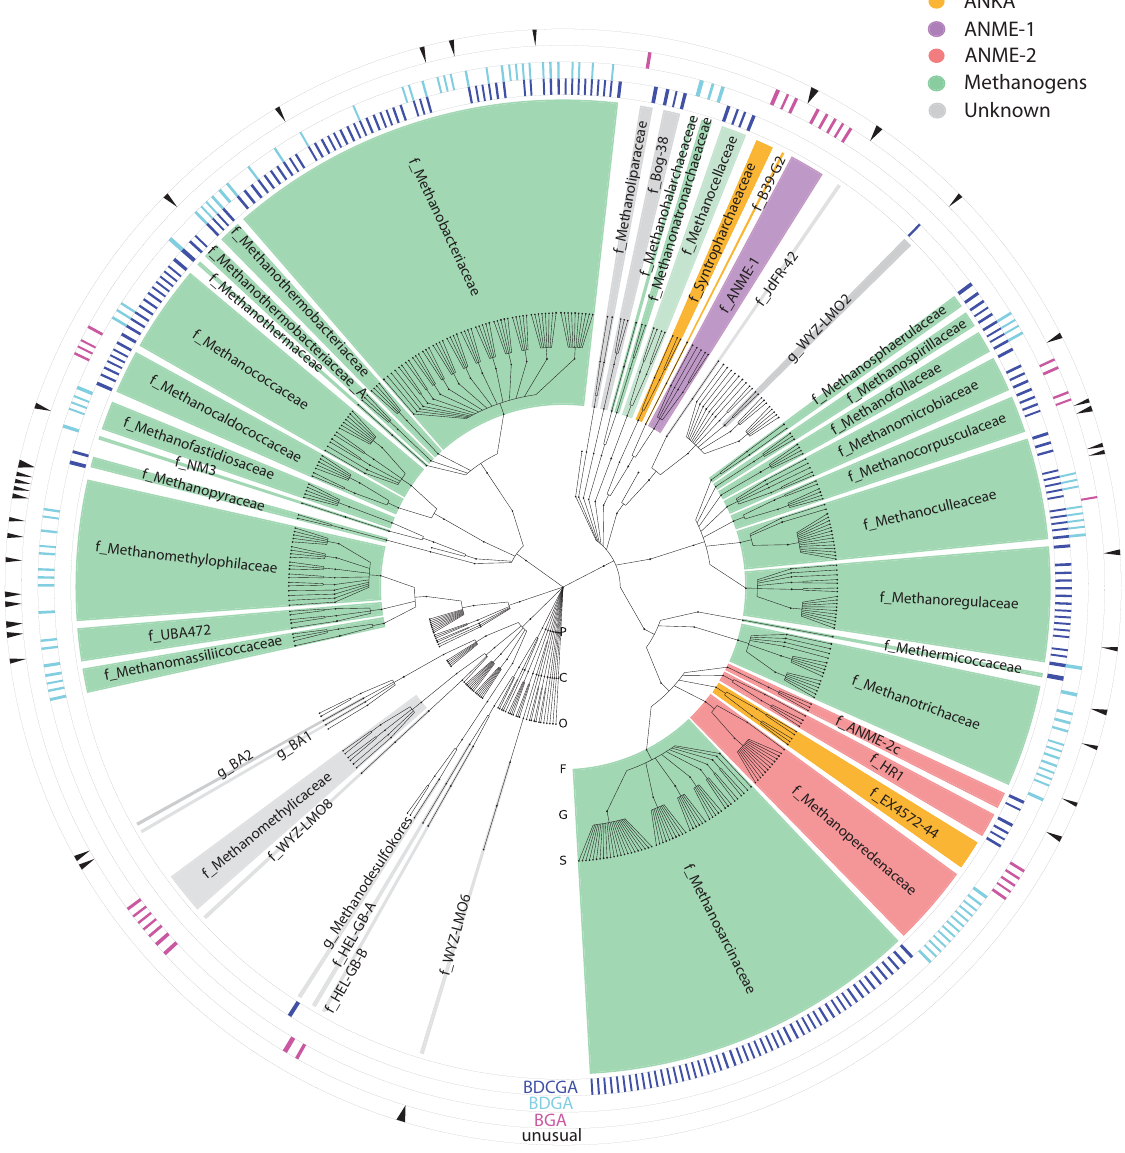
Fig. 1 Distribution and gene clusters of mcr among archaea. A total of 307 mcr genes were identi fi ed from 1070 archaeal genomes including methanogens ( n = 252), ANME-1 clade ( n = 5), ANME-2 ( n = 20), ANKA ( n = 9), and other archaea with unknown metabolism ( n = 21). Accession numbers are given in Supplementary Data 1. Color shading: green, methanogens; purple, ANME-1 archaea; red, ANME-2 archaea; orange, proposed ANKAs; gray, archaea containing mcr with unknown functions. The operon structures ( mcrBDCGA , mcrBDGA , or mcrBGA ) are represented by multiple rings outside the rank-normalized phylogenetic tree. BDCGA (in blue), mcrBDCGA operon; BDGA (in cyan), mcrBDGA operon; BGA (in magenta), mcrBGA operon; unusual (in black), mcr genes lack the three recognized common operon structures. Multiple hits of a single genome indicate the presence of multiple copies of mcr . Taxonomic classi fi cation: P phylum, C class, O order, F family, G genus, S species. Lineages without mcr were truncated at the order assembled with F 430 , whereas the CA tag reduced the F 430 content identi fi ed in addition to the McrB, G, A subunits. In all three cases, the MCR aeo yields were ∼ 6% of total cellular proteins, by 30% (Fig. 2c). Therefore, tag locations affected F 430 assembly, suggesting that tag locations did not affect the protein production and the NB and NG tags were suitable for productions of the level. The ultraviolet-visible (UV – vis) spectra of the puri fi ed holo-MCR. Lastly, the presence of PTMs — including thioglycine, MCR aeo exhibited a maximal absorption peak at 425 nm, which 1- N -methylhistidine, 5-( S )-methylarginine, and 2-( S )-methylglu- was typical for the MCR holoenzyme and slightly lower than the absorption maximum of methanol-extracted F 430 at 430 nm (Fig. 2c). Based on the molar extinction coef fi cient ε 430nm = plementary Table 1). This indicated that our heterologous expression system resulted in the same PTMs as found for the M. 22,500 M − 1 cm − 1 and an HPLC-based analysis (Supplementary Fig. S1), the puri fi ed MCR aeo with NB or NG tags was fully